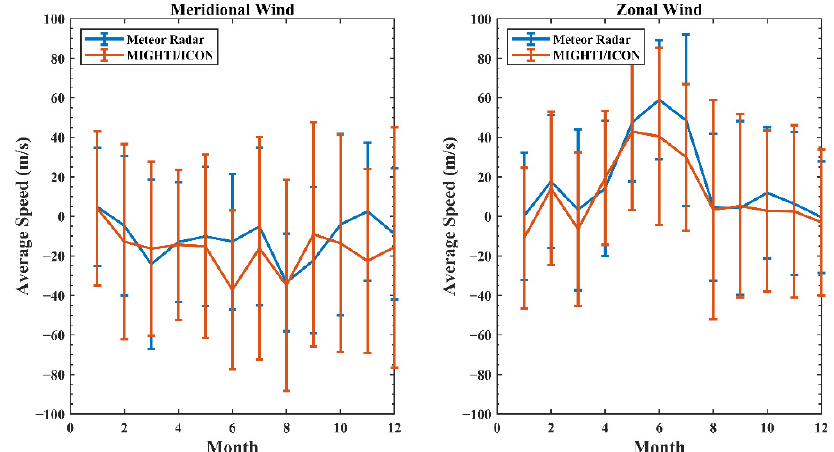
Figure 7. The monthly variations in monthly average of horizontal winds. The error bars are the standard deviation of the monthly average of horizontal winds. The left column shows the meridional winds and the right column shows the zonal winds.